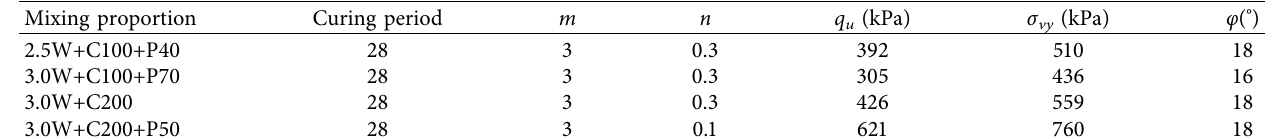
Figure 10: Comparisons between simulation results and test data: (a) 2.5W+C100+P40 and 3.0W+C200+P50; (b) 3.0W+C100+P70 and 3.0W+C200. Table 4: Values of parameters for strength criterion verification.